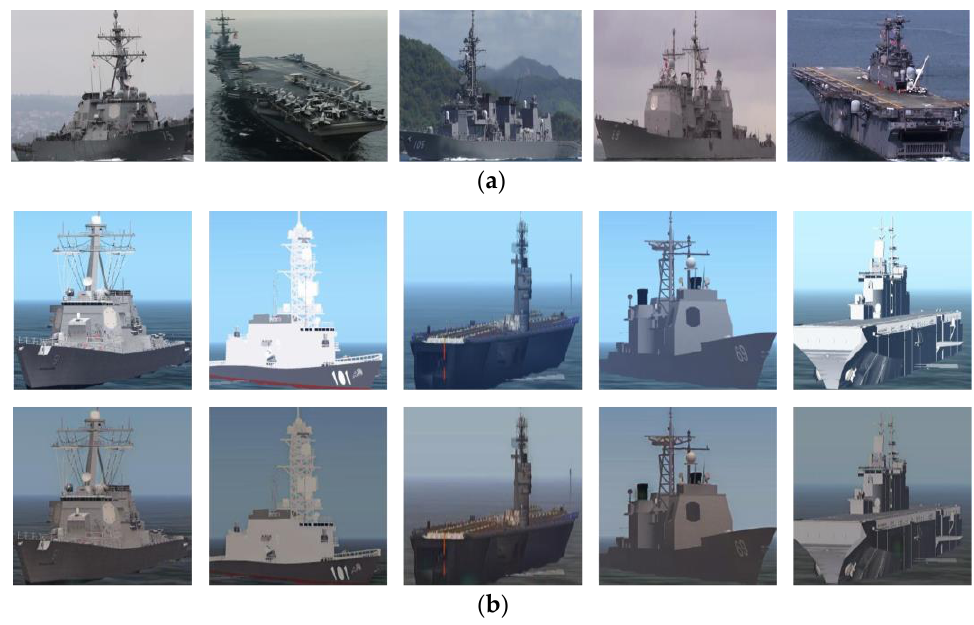
Figure 9. Style images and results. ( a ) Some style images selected from real samples. ( b ) Original simulation images and results processed by style transfer.